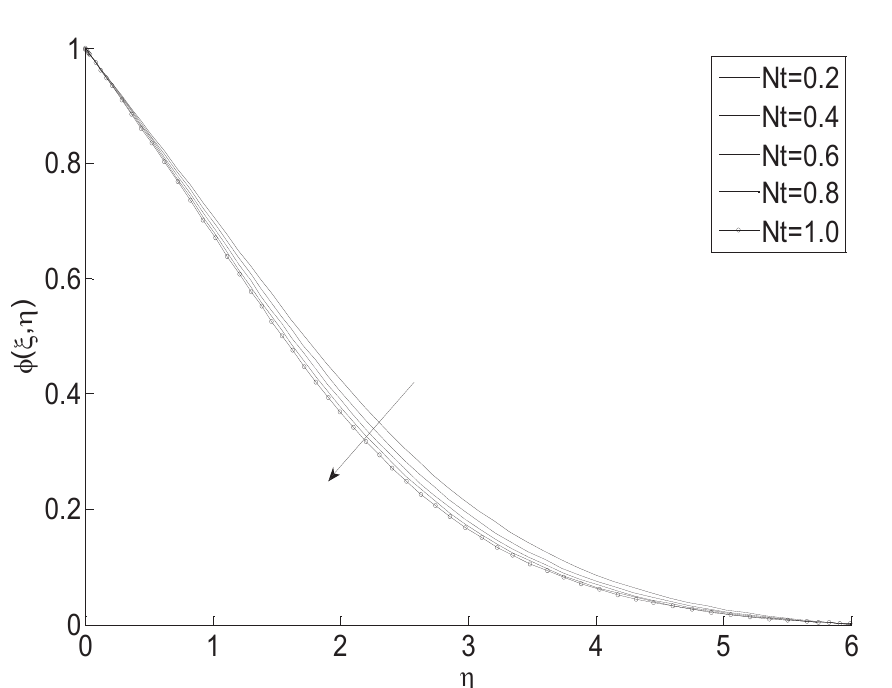
Figure 8. Concentration profiles for different thermophoretic parameters at ξ = 1.0, n = 1.0, Sc = 1.0, N = 1.0, γ = 2.01, ε = 0.45, f w = 0.0, and κ = 0.5.